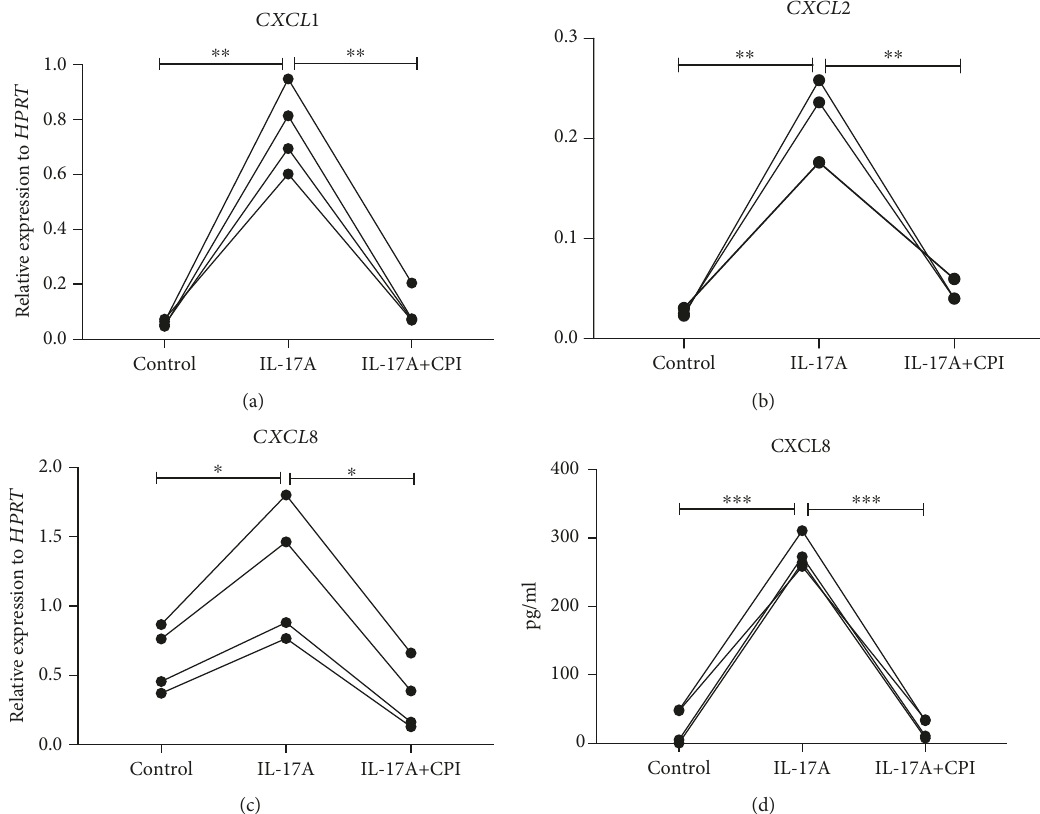
Figure 6: Induction of proin fl ammatory chemokines is dependent on BET. Human bronchial epithelial cell line HBE1 cells were plated 0.08-0.15 million cells per well in a 12-well plate. After incubating with BronchiaLife ™ Epithelial Airway Medium overnight, cells were treated with control medium, 100ng/ml h-IL-17A protein, 200nM CPI, and 100ng/ml h-IL-17A plus 200nM CPI, respectively. 6h after stimulation, (a) CXCL1 , (b) CXCL2 , and (c) CXCL8 mRNA levels were determined by RT-PCR. (d) 24h after stimulation, supernatant was collected and CXCL8 protein level was measured by ELISA. ∗ p < 0 05 ; ∗∗ p < 0 01 ; ∗∗∗ p < 0 001 ; by a one-way ANOVA test. It is the representative fi gure from 4